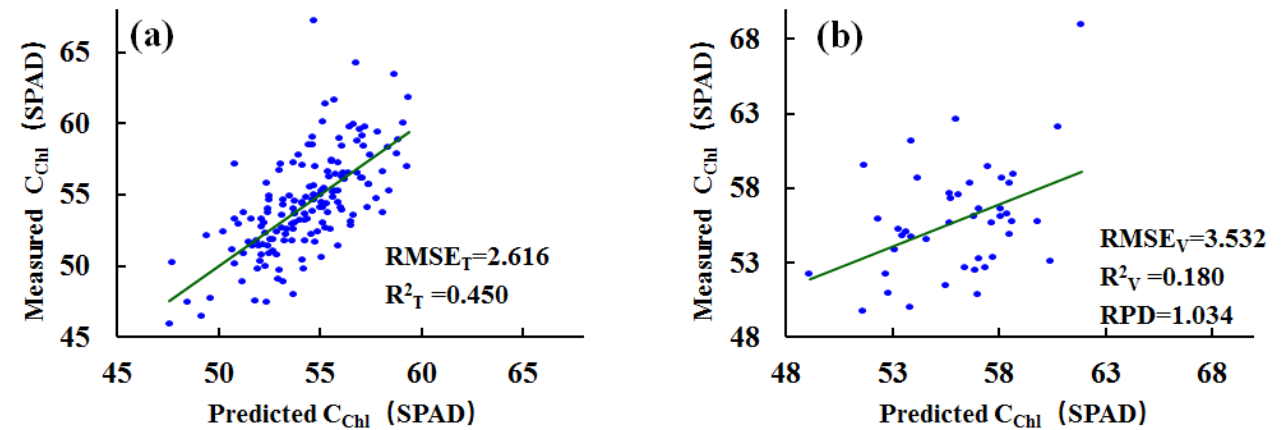
Figure 10. The estimated results of SPAD value for ( a ) training set and ( b ) validation set based on pretreatment WPD-(1/R)’-PCADR at jointing stage.